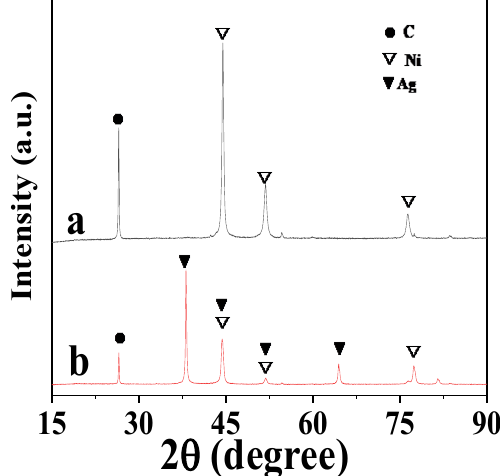
Figure 1. XRD patterns of the samples: (a) Ni/C powders; (b) Ag/Ni/C powders. The elemental distributions and percentages of the samples were examined by ele- mental mapping and energy-dispersive X-ray spectrometry (EDS) (Figure 2). EDS analyses indicated that the elemental percentages of C, O, and Ni in Ag/Ni/C powder significantly decreased in comparison with those in Ni/C powder, and the dominant element in the surface layer of Ag/Ni/C was found to be Ag (83.26 wt.%), confirming the successful deposition of Ag on Ni/C powder (Figure 2a,b). Furthermore, elemental mapping analyses demonstrated the presence and uniform distribution of Ag on the powder surface after the coating process, confirming the successful coating of Ag nanoparticles on Ni/C powder (Figure